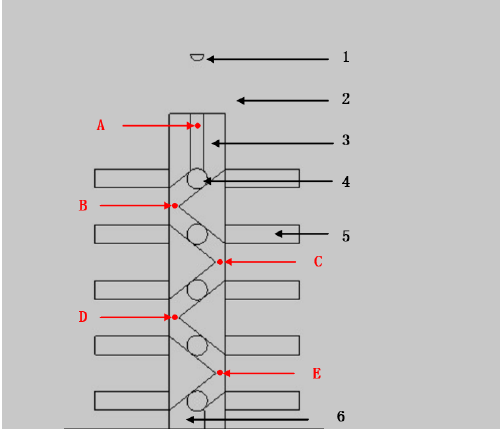
Figure 6. Simulation model